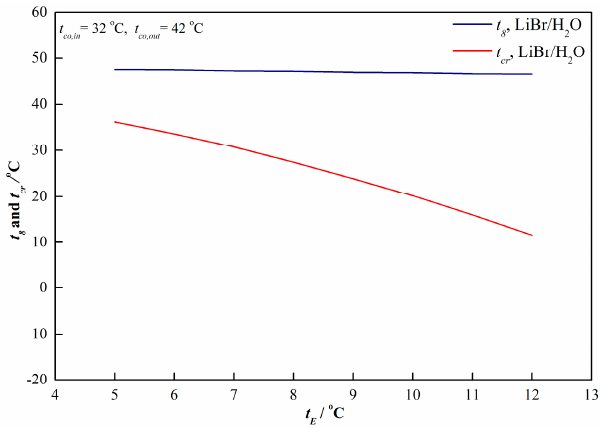
Figure 7. Variations of t 8 and t cr for LiBr / H 2 O with the evaporation temperature t E .